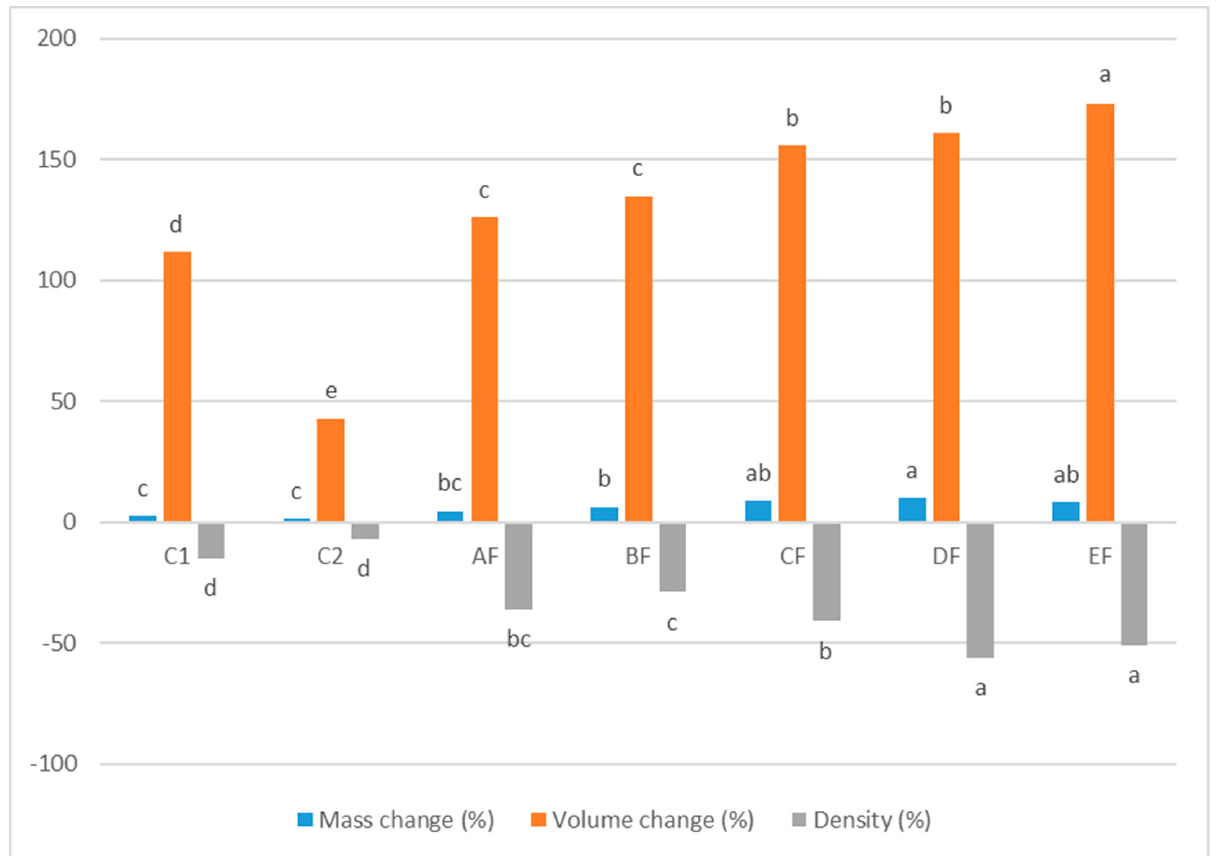
Figure 1. Physical properties of gluten-free doughnut with different treatments: AF (15%), BF (30%), CF (45%), DF (60%) and EF (75%) Lupin flour: potato starch and corn flour composite, (C1) based on wheat flour; (C2) based on potato starch and corn flour composite. Different letters for different treatments mean they are significantly different ( p ≤ 0.05) based on Duncan’s multiple range test.